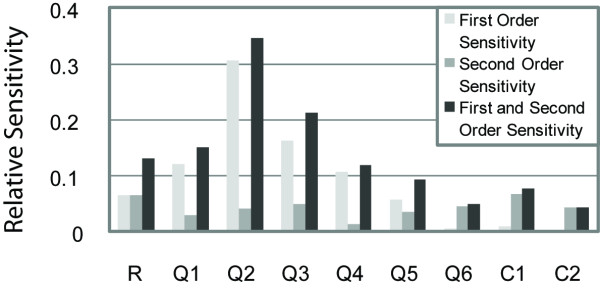
Sensitivity analysis using the HDMR global sensitivity method on the thermodynamic model of Fakhouri et al., scheme 2. Shown are first-, second- and the sum of first- and second-order sensitivity indices, which represent the amount of variation in the model output with respect to each parameter individually (light gray bars), each pair of parameters (dark gray bars), and the sum of these two variations (black bars), scaled from 0.0 to 1.0. General sensitivity trends are similar to those observed in Figure 2, although second-order sensitivities are largest for R and C1, implying that they affect the model output through pair-wise interactions with other parameters. Over 95% of the variation in model output was found using only first- and second- order sensitivities (data not shown); therefore the sum of first- and second-order sensitivities shown here approximates the total sensitivity of each parameter.